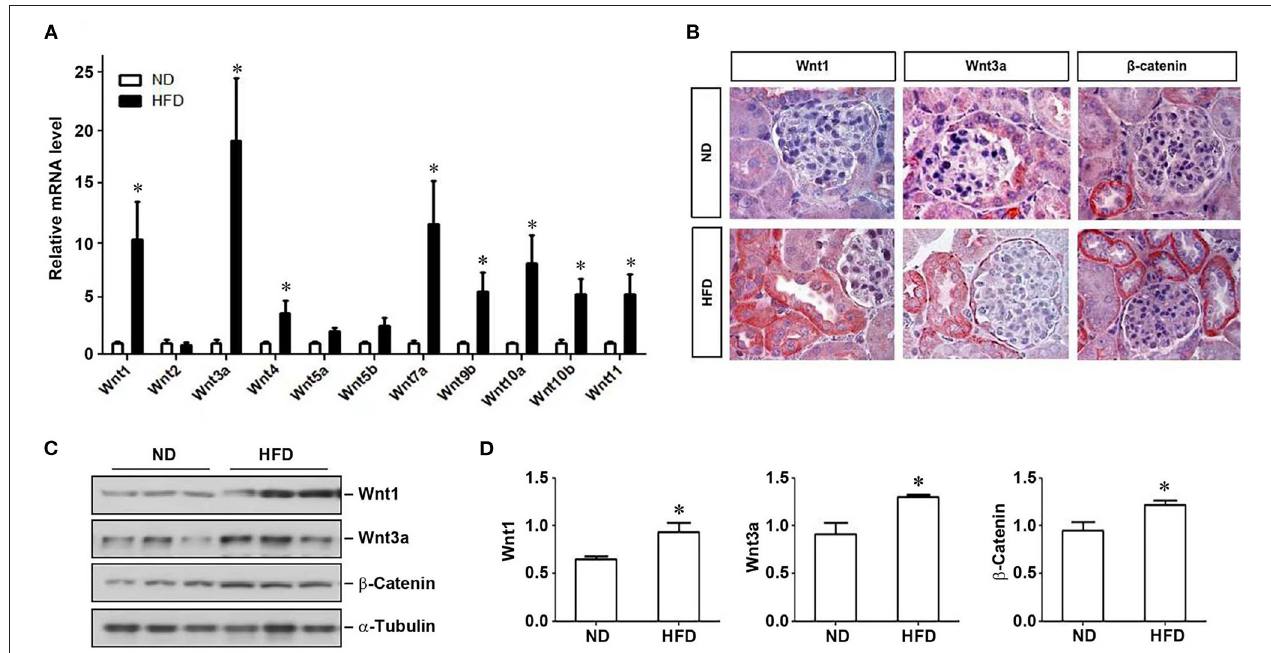
FIGURE 2 | Activation of Wnt signaling pathway in mice on a high-fat diet. After 12 weeks of a high-fat diet in mice, kidney tissues were collected to detect the expression of Wnt family members by real-time RT-PCR (A) , the localization and expression of Wnt1, Wnt3a and β -catenin in kidney tissues by immunohistochemistry (B) and western blot (C) , respectively. (D) Quantitative determination of the expression levels of various proteins as indicated by densitometry and normalized with α -tubulin. ND, normal diet; HFD, high-fat diet; * P < 0.05, ND vs. HFD, n =